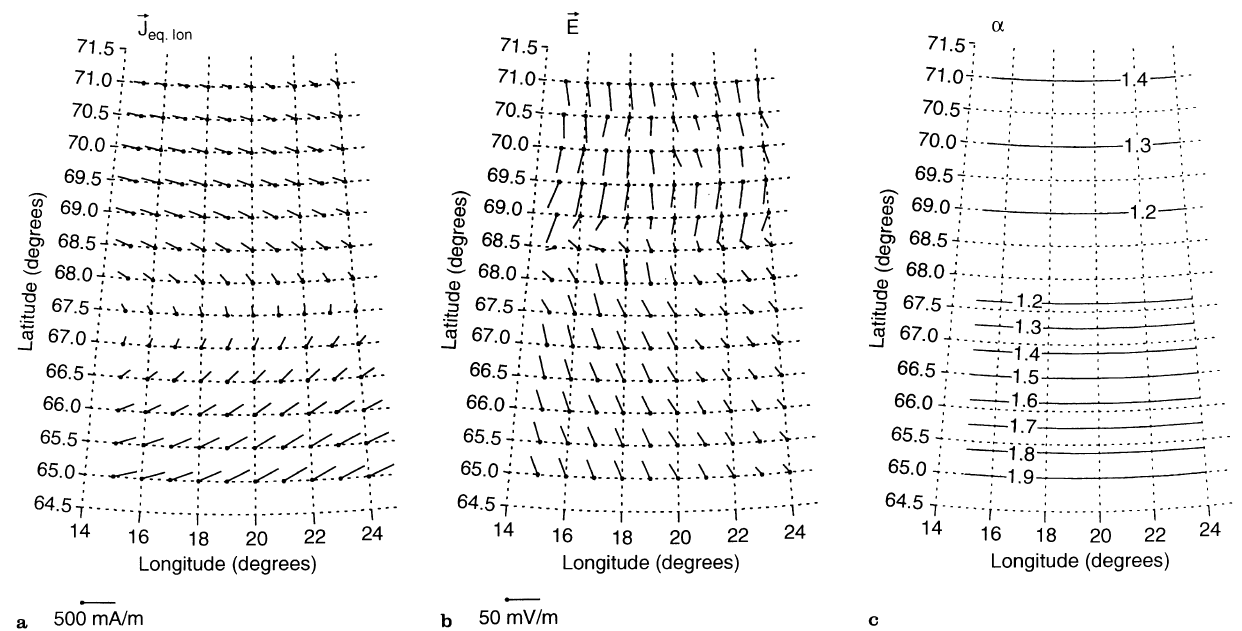
field. c Modeled distribution of Hall-to-Pedersen conductance ratio [modeled with respect to results of Lampen (1985) and Kunkel et al